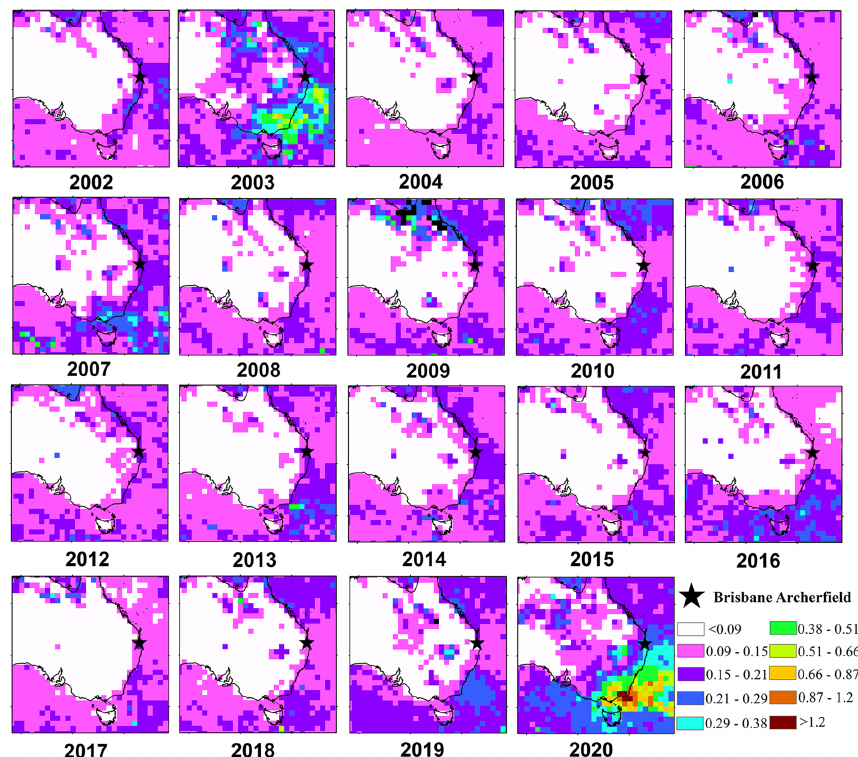
Figure 9. The spatial distribution of aerosol optical depth (AOD) of total aerosols in eastern Australia during January from 2002 to 2020 using the Moderate Resolution Imaging Spectroradiometer (MODIS) AOD product.